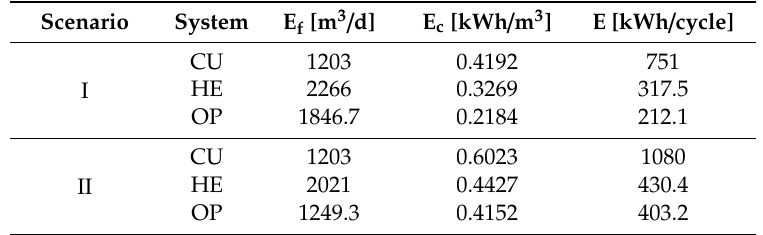
Table 2. Comparison of e ffi ciency, energy cost and energy to perform a single work cycle.